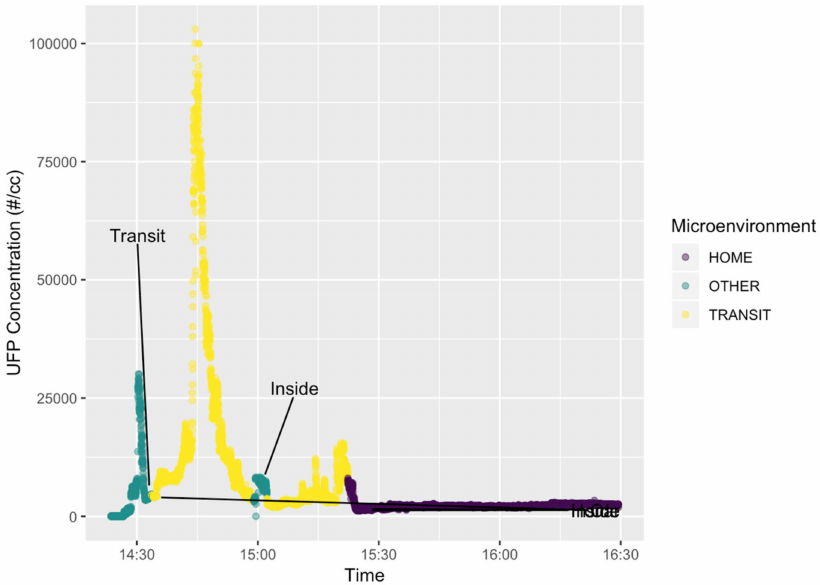
Figure 3. Plot of UFP exposure, colored by microenvironment, participant # 300012 (28 February